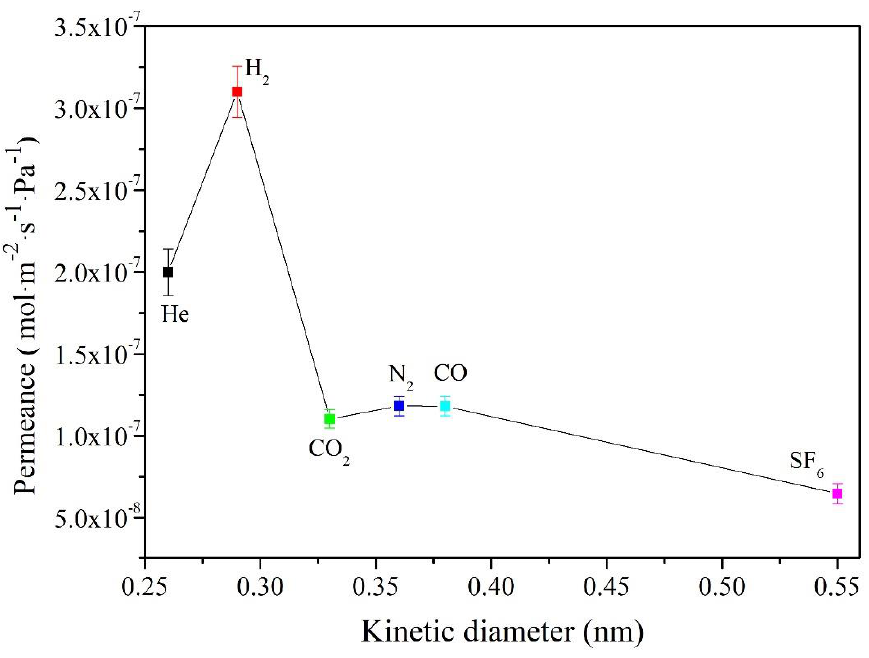
Figure 7. Permeation flux of single gas He, H 2 , CO 2 , N 2 , CO, and SF 6 on AlPO 4 -5 membrane at 298 K. The standard deviations of the permeate flux data are presented with error bars of 5%.